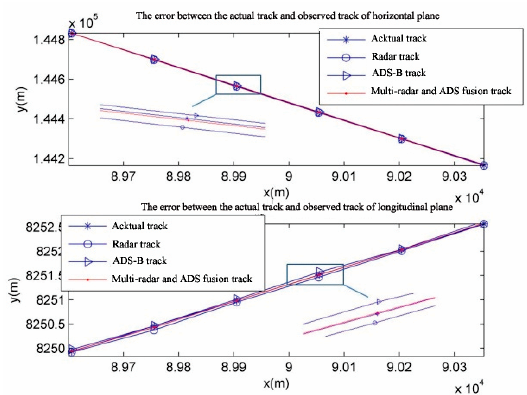
Figure 8. Observed track with weighted fusion.